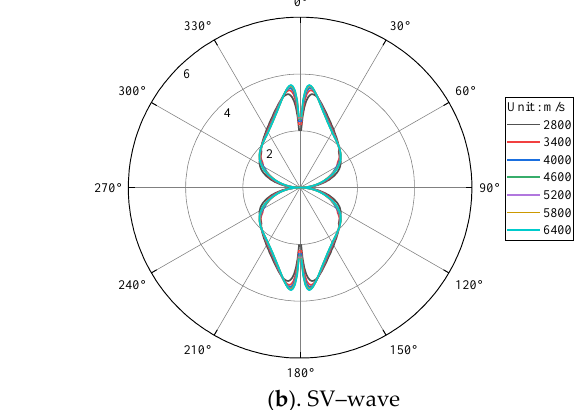
Figure 5. Radiation characteristics of SH – wave and SV – wave of a dipole source under different formation compressional velocities.